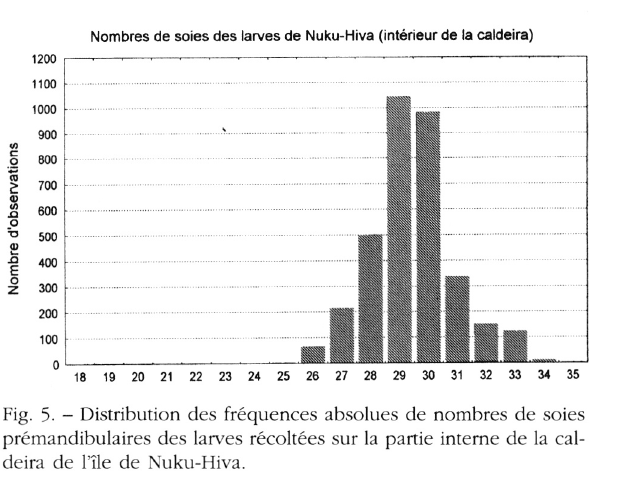
Fig. 5. - Distribution des fréquences absolues de nombres de soies prémandibulaires des larves récoltées sur la partie interne de la cal- deira de l'île de